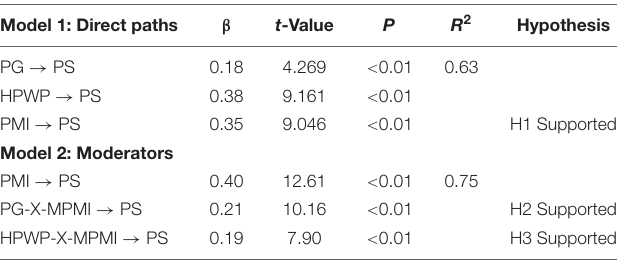
TABLE 5 | CB-SEM estimations for hypothesis